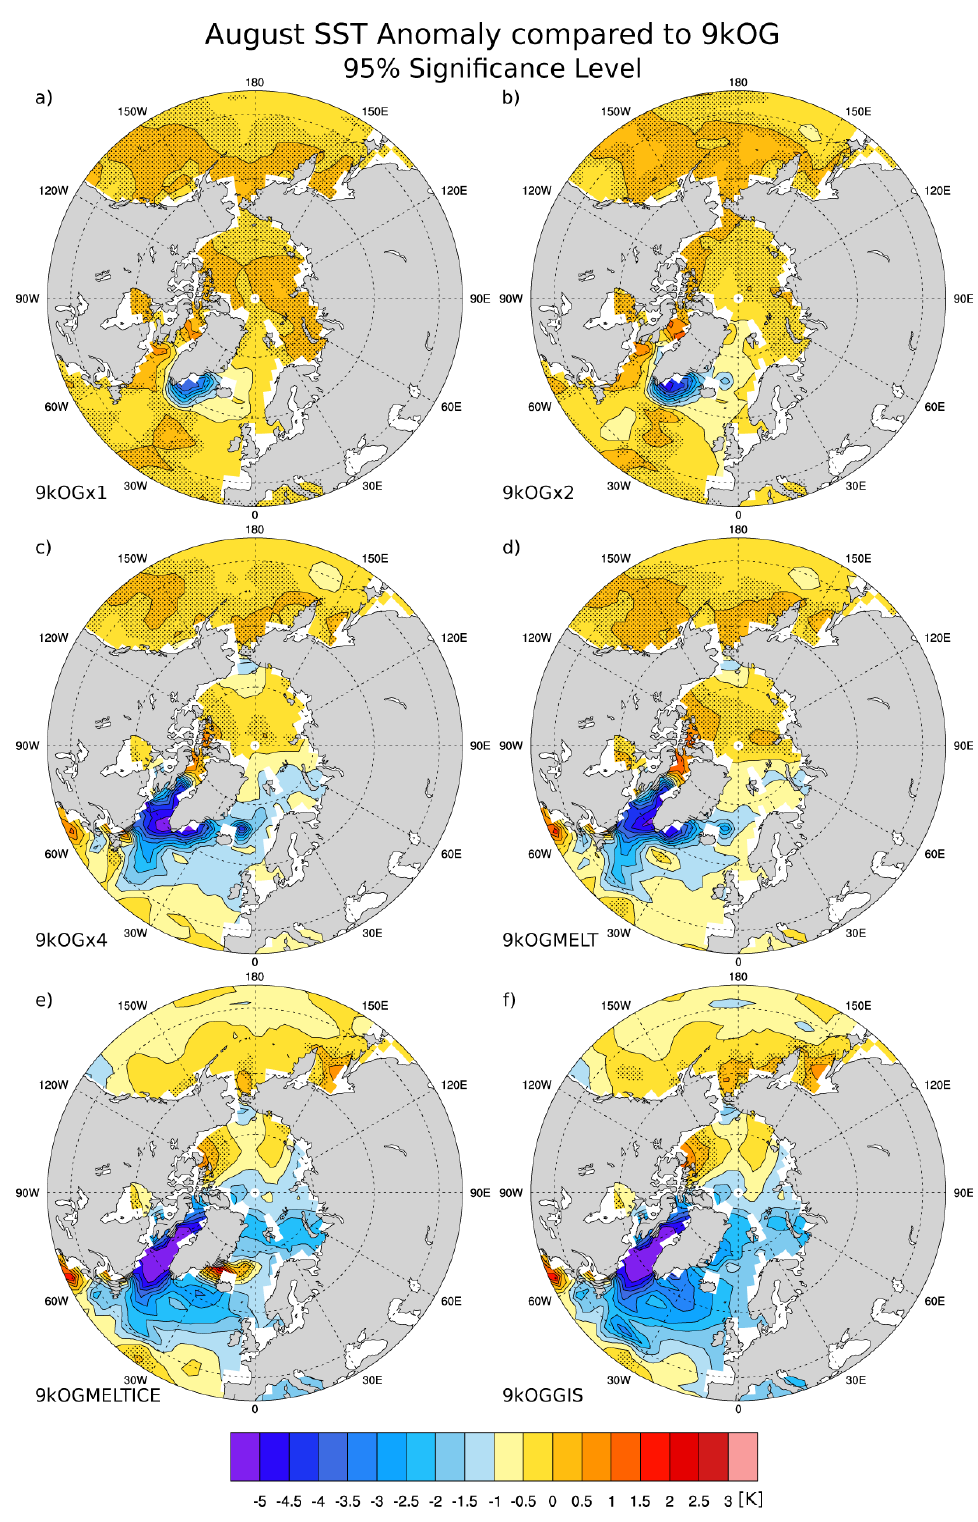
Fig. 2. Sea surface temperature (SST, scale in K) anomaly compared to 9kOG for 9kaBP snapshot simulations. Values are calculated from the last 100yr of each experiment. Shaded area denotes insignificant changes compared to 9kOG according to a Student’s t test. (a) 9kOGx1 SST anomaly for GIS melt (13mSv). (b) 9kOGx2 SST anomaly for GIS melt (26mSv). (c) 9kOGx4 SST anomaly for GIS melt (52mSv). (d) 9kOGMELT SST anomaly for LIS melt (0.09Sv). (e) 9kOGMELTICE SST anomaly for LIS melt (0.09Sv) + remnant ice sheet (albedo + topography). (f) 9kOGGIS SST anomaly for LIS melt + remnant ice sheet+additional GIS melt